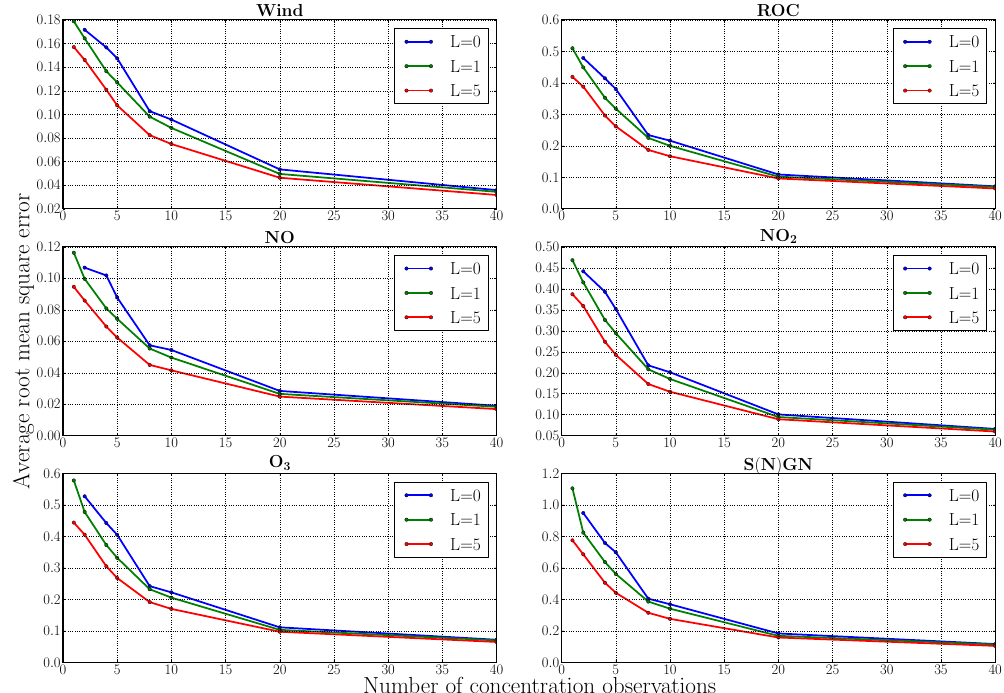
Figure 8. Average filtering analysis RMSEs of the L95-GRS variables, as a function of the number of concentration observations for the IEnKS with three DAW lengths. The case L = 0 corresponds to the ensemble transform EnKF. The RMSEs are normalised by the standard deviations of the observation